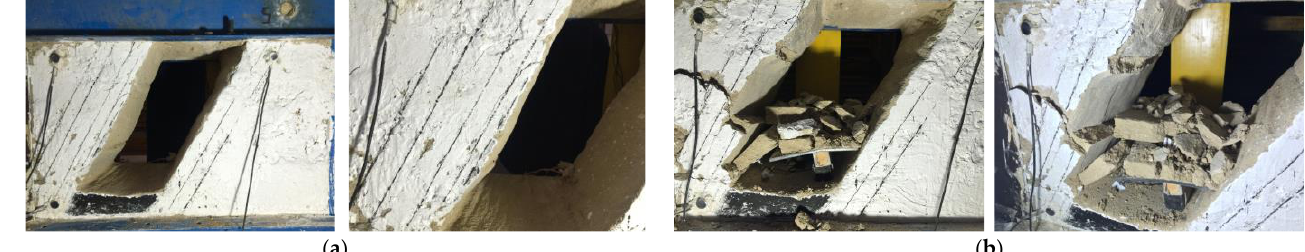
Figure 6. Roof breaking characteristics. ( a ) Tier 6 and Local magnification. ( b ) Dynamic load applied on the sixth layer and Local magnification